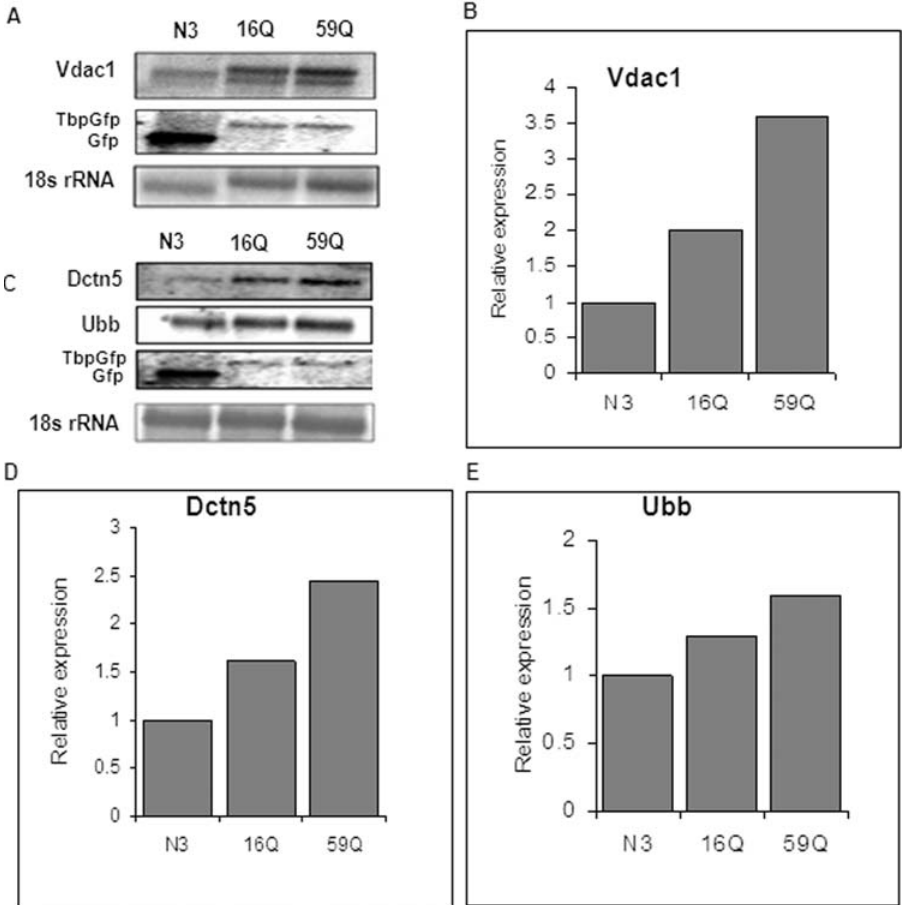
Figure 3. Differential expression of Vdac1 gene, Dctn5 and Ubb in Neuro-2a cells transfected with N3, 16QTBPGFP and 59Q TBPGFP. (A & C) Northern blot using Vdac1 (A), Dctn5 and Ubb as a probe (C), Gfp probe was used to show expression levels of Gfp and TbpGfp in transfected cells (A, C), 18s rRNA was used as a loading control (lower panels in A & C); (B, D & E) The intensity of Vdac1 (B), Dctn5 (D) and Ubb (E) band were quantified and each band intensity was normalised to the band of 18s rRNA. N3 band intensity was used for determining relative expression. N3: tranfected construct contains GFP; 16Q, 59Q: transfected construct contains GFP tagged hTBP with CAG repeat length 16 and 59 respectively.